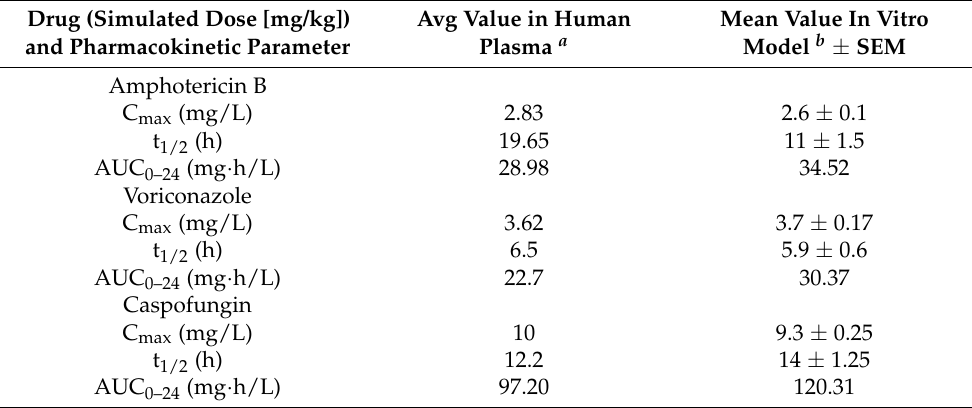
Table 1. Pharmacokinetic parameters of amphotericin B, caspofungin, and voriconazole in humans and in vitro PK/PD model, reprinted with permission from Ref. [22]. Copyright 2012, American Society for